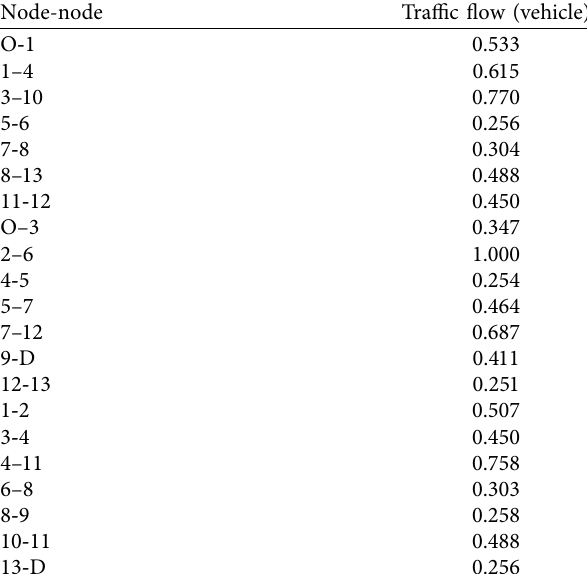
Table 7: Table of trafc fow.